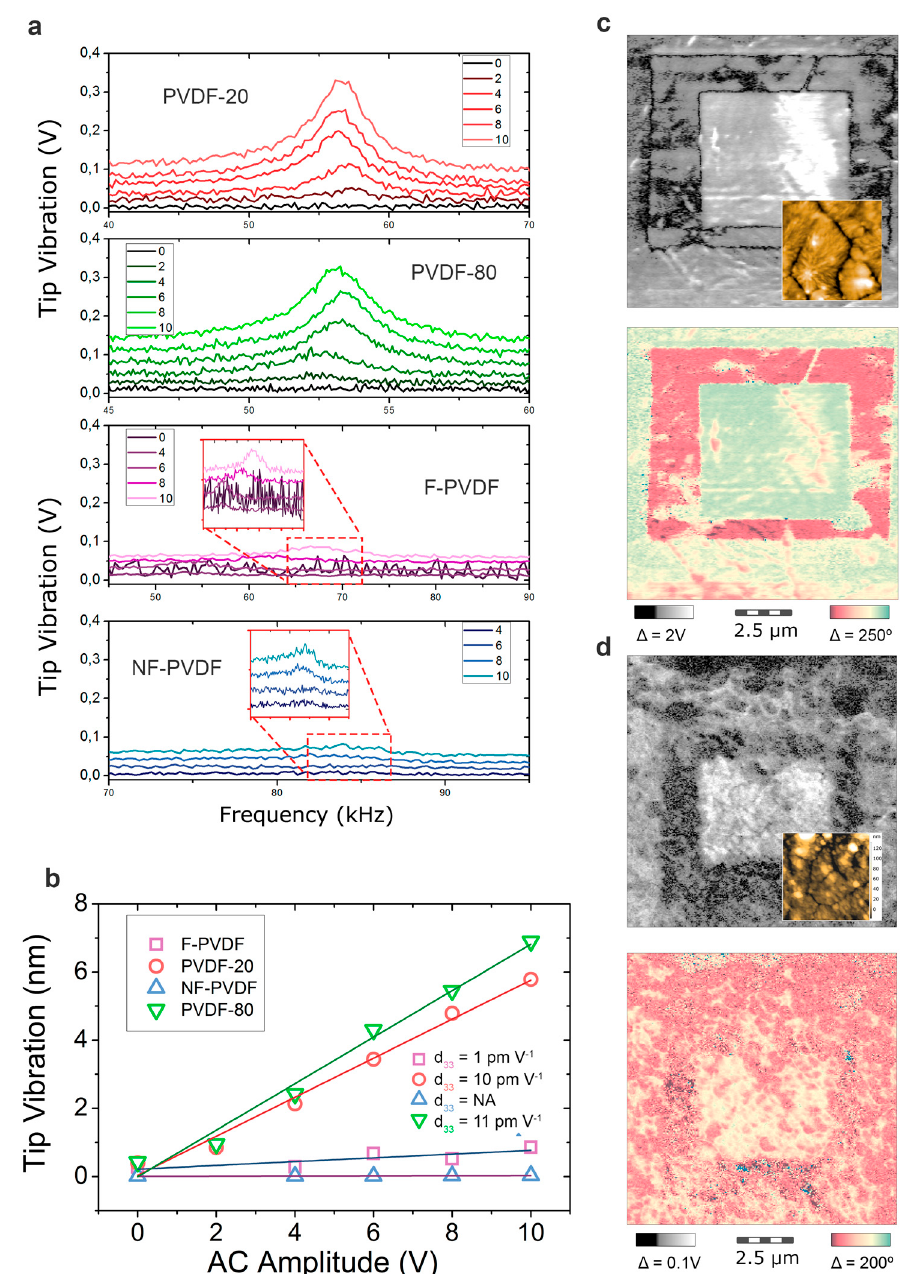
Figure 5. ( a ) Tip vibration as a function of the frequency for an AC voltage within 0–10 V by a step of 2 V; ( b ) linear piezoelectric response of the four samples; ( c ) PFM amplitude (top) and phase (bottom) of the PVDF ‐ 20 film; ( d ) PFM amplitude (top) and phase (bottom) of the F ‐ PVDF film. The maximum electric field applied at 10 V was 133 MV/m for the NF ‐ PVDF thin film (75 nm thick) and 100 MV/m for PVDF ‐ 20 (99 nm thick). For details on the thickness of all the samples, see Supplementary Materials Table S1. The polarized opposite squared areas in ( c ) and ( d ) were obtained by applying a positive and negative DC voltage of 5 V, respectively, for a 10 × 10 μ m square and a 5 × 5 μ m one. Thus, the maximum electric field applied for the ( c ) PVDF ‐ 20 film was ±50 MV/m and ±66 MV/m for the ( d ) F ‐ PVDF. The PFM amplitude and phase for both samples were then imaged using a AC modulation voltage of 5 V.